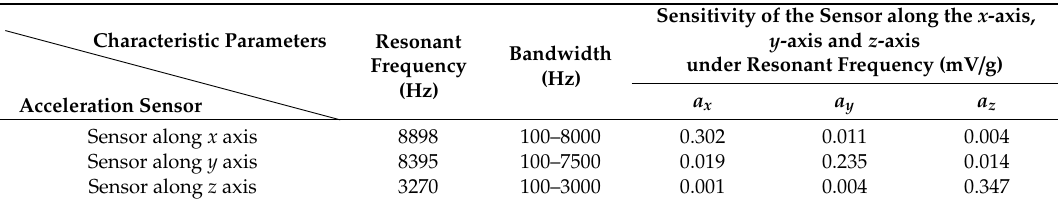
Table 4. The characteristic parameters of the AS-6